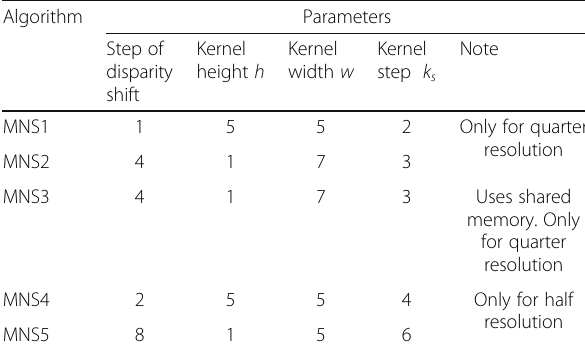
Table 4 Cyclops2 MNS methods and their relevant parameters used in the evaluation